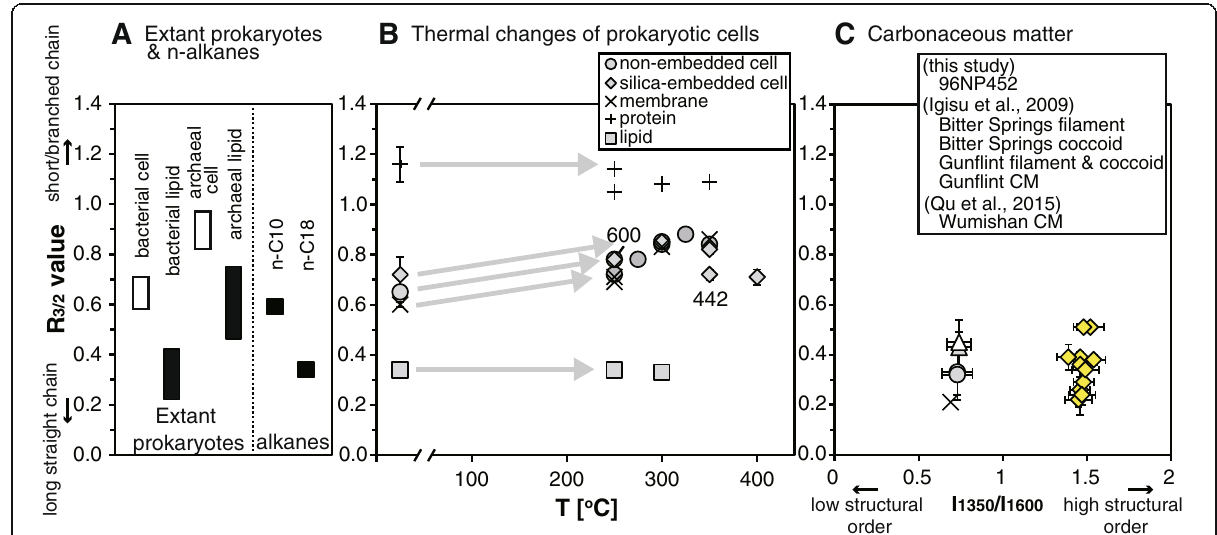
Fig. 7 R 3/2 values of the extant prokaryotes, experimentally maturated cyanobacteria, and the carbonaceous clots. a R 3/2 values of the extant bacterial and archaeal cells and lipids (data from Igisu et al. 2012) together with the standard n-alkane samples (n-C 10 and n-C 18 ) (data from Igisu et al. 2009). The R 3/2 values for the representative extant untreated bacterial and archaeal cells range from 0.59 ± 0.01 to 0.70 ± 0.01 and from 0.86 ± 0.04 to 0.95 ± 0.02, and those for bacterial and archaeal lipids range from 0.31 ± 0.09 to 0.41 ± 0.01 and from 0.51 ± 0.05 to 0.67 ± 0.08, respectively. b Results of the heating experiments for the non-embedded and silica-embedded cyanobacterial cells (modified from Igisu et al. 2009, 2018). The R 3/2 values for the heated samples are plotted against the heating temperature. All the experimental run products of the silica- embedded samples were obtained after heating for 600 min except the one indicated by a number (the sample marked was heated for 442 min). Others were obtained after heating for 300 min except the one indicated by a number (the sample marked was heated for 600 min). c R 3/2 values of the carbonaceous clots obtained from the Dresser Formation together with the Proterozoic prokaryotic fossils and carbonaceous matter (CM) in stromatolite. The error bars for the carbonaceous clots indicate the standard deviations of the duplicate measurements. The data for Bitter Springs and Gunflint samples were obtained from Igisu et al. (2009), and that for Wumishan sample was obtained from Qu et al.